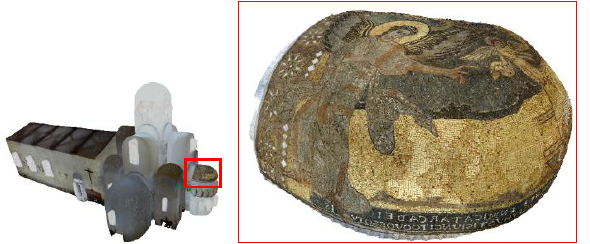
Figure 4. Area of interest in perspective view (left), localization of the mosaic in the front apse of the oratory (right)